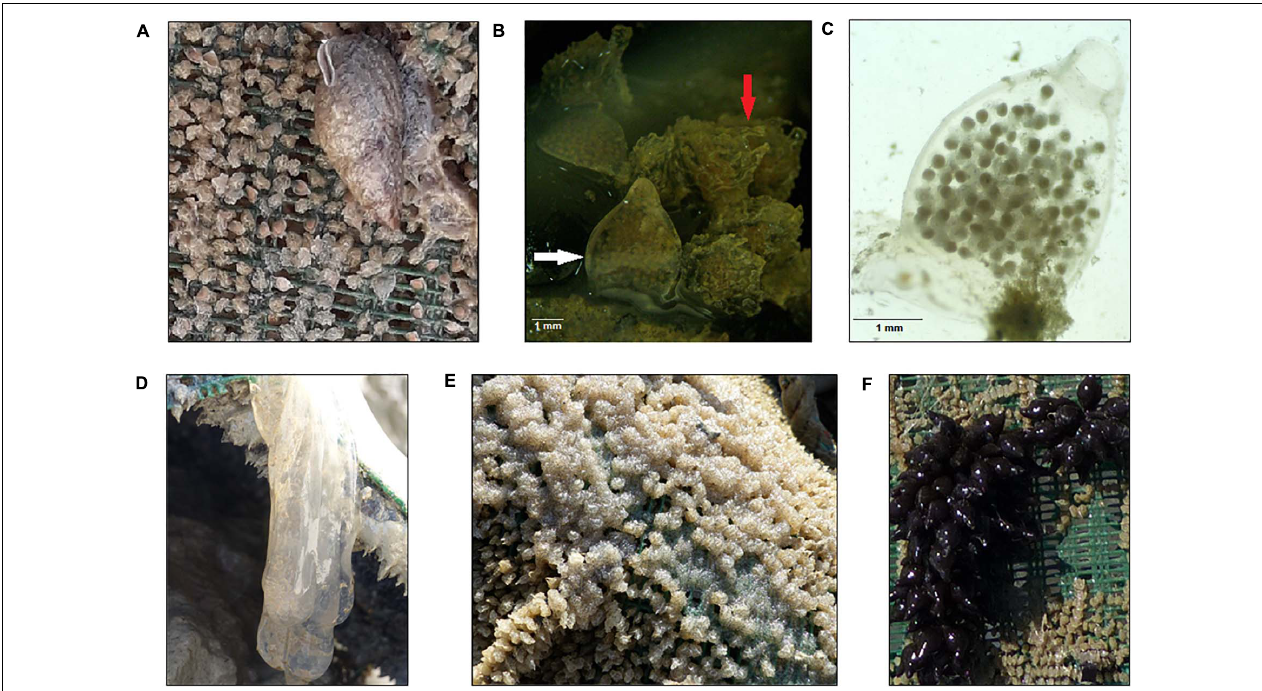
FIGURE 4 | Artificial substrates favor egg deposition by different species, including other common marine snails. Tritia reticulata specimen (A) , comparison between Tritia reticulata (white arrow) and Tritia mutabilis (red arrow) egg capsules (B) , stereomicroscopic image of Tritia reticulata egg capsule (C) , squid (D) , octopus (E) , and cuttlefish eggs (F)